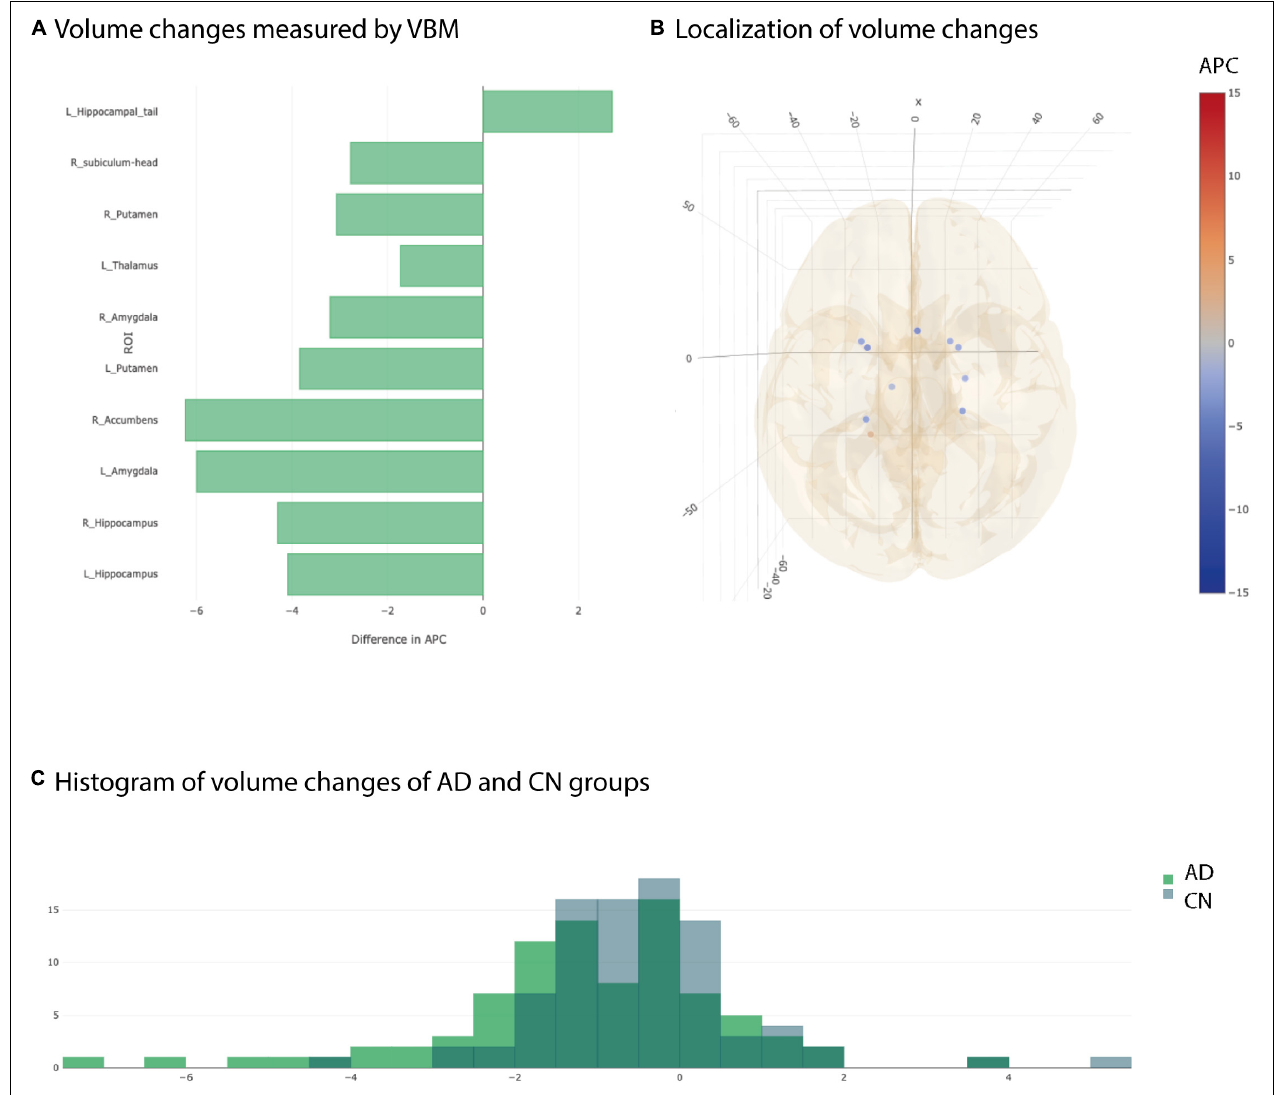
FIGURE 2 | Significant differences at individual testing level of annual percent changes measured by longitudinal Voxel Based Morphometry. (A) Horizontal bar plot of significant differences in group averaged volume changes (longitudinal VBM) between AD and CN groups. Bars to the left indicate a stronger decrease in APC values in AD group than in CN group. (B) 3D lattice graph of ROIs with significant differences in APC values corresponding to panel (A) . Each circle is located at the center of mass of the corresponding ROI in MNI152 coordinate space. Color code indicates extend and sign of APC group differences whereas the diameter indicates absolute effect size. Brain hull was derived from a T1-weighted MR image in MNI152 standard space. (C) Overlaid histograms of the AD and CN group showing the group averaged APC values of all ROIs (including those with significant and non-significant differences).